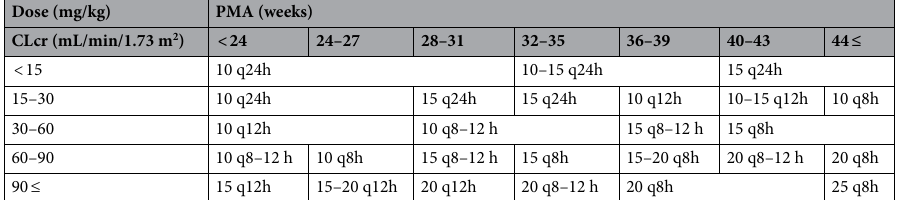
Dose (mg/kg) PMA (weeks) CLcr (mL/min/1.73 m 2